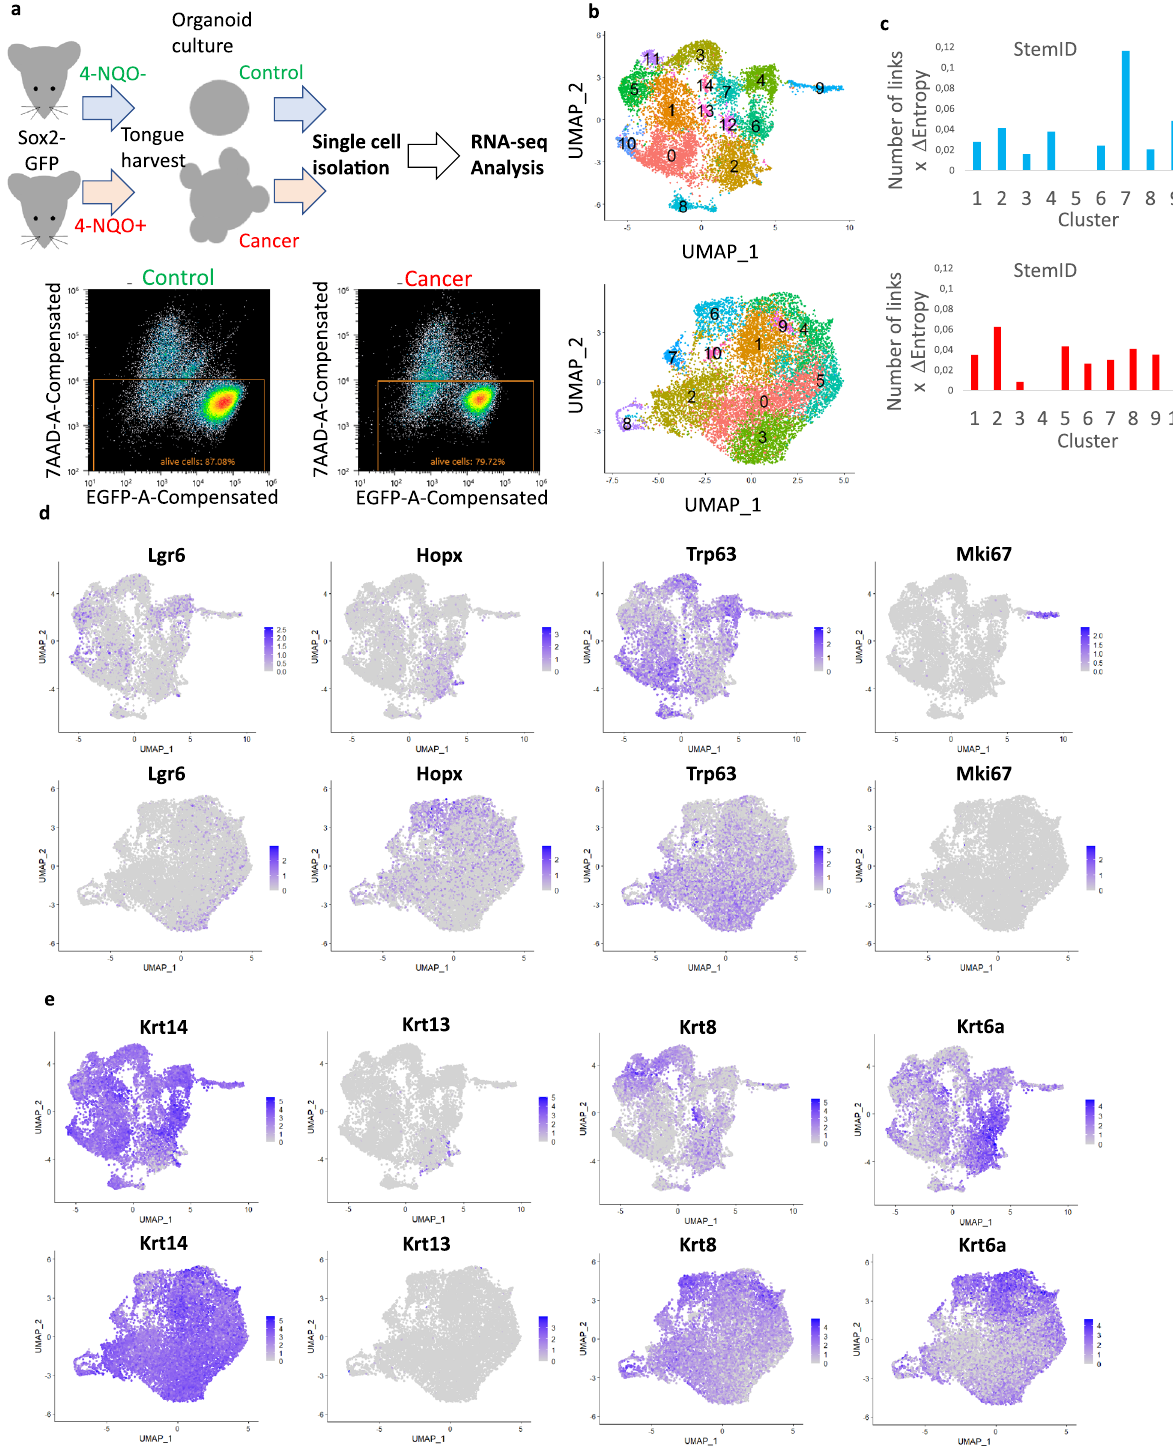
Figure 2. Single-cell RNA sequencing analysis of control and cancer organoids. ( a ) Scheme for single-cell isolation and RNA sequencing analysis of control and cancer lingual epithelial organoids from untreated and 4-nitroquinoline-1-oxide (4-NQO)-treated mice. The plots for sorting of alive cells for single-cell RNA sequencing. ( b ) Uniform manifold approximation and projection (UMAP) plots of control (upper panel) and cancer (lower panel) organoid Seurat datasets labeled by Seurat clusters. ( c ) Bar charts of StemID values for RaceID clusters in control (upper) and cancer (lower) organoid datasets. ( d ) UMAP plots showing the expression of epithelial stem cell and proliferation markers in control (upper panel) and cancer (lower panel) Seurat objects. ( e ) UMAP plots showing the expression of keratin genes in control (upper panel) and cancer (lower panel) Seurat